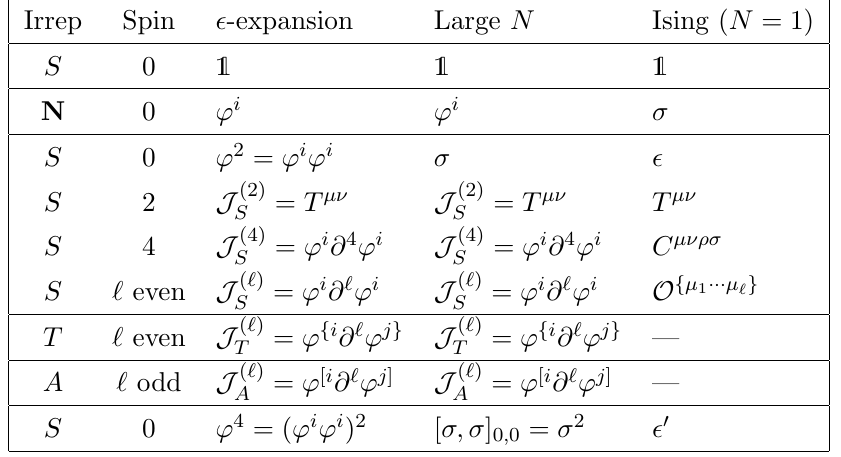
Table 1 . Some operators with low twist and their names in the di(cid:11)erent